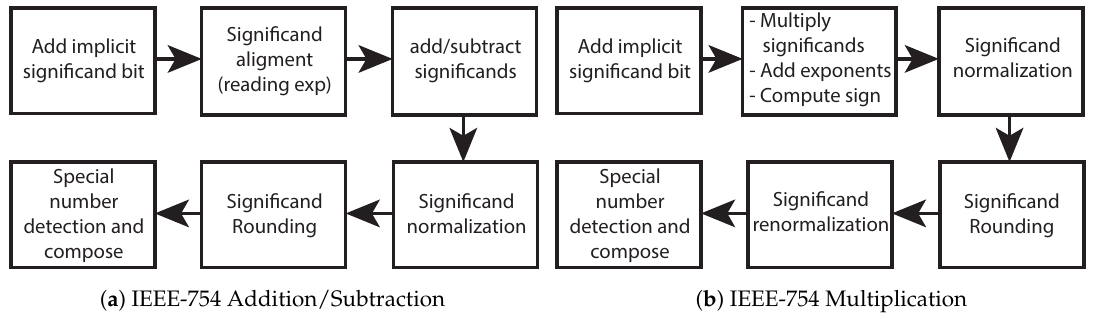
Figure 3. IEEE-754 algorithm for adding/subtracting and